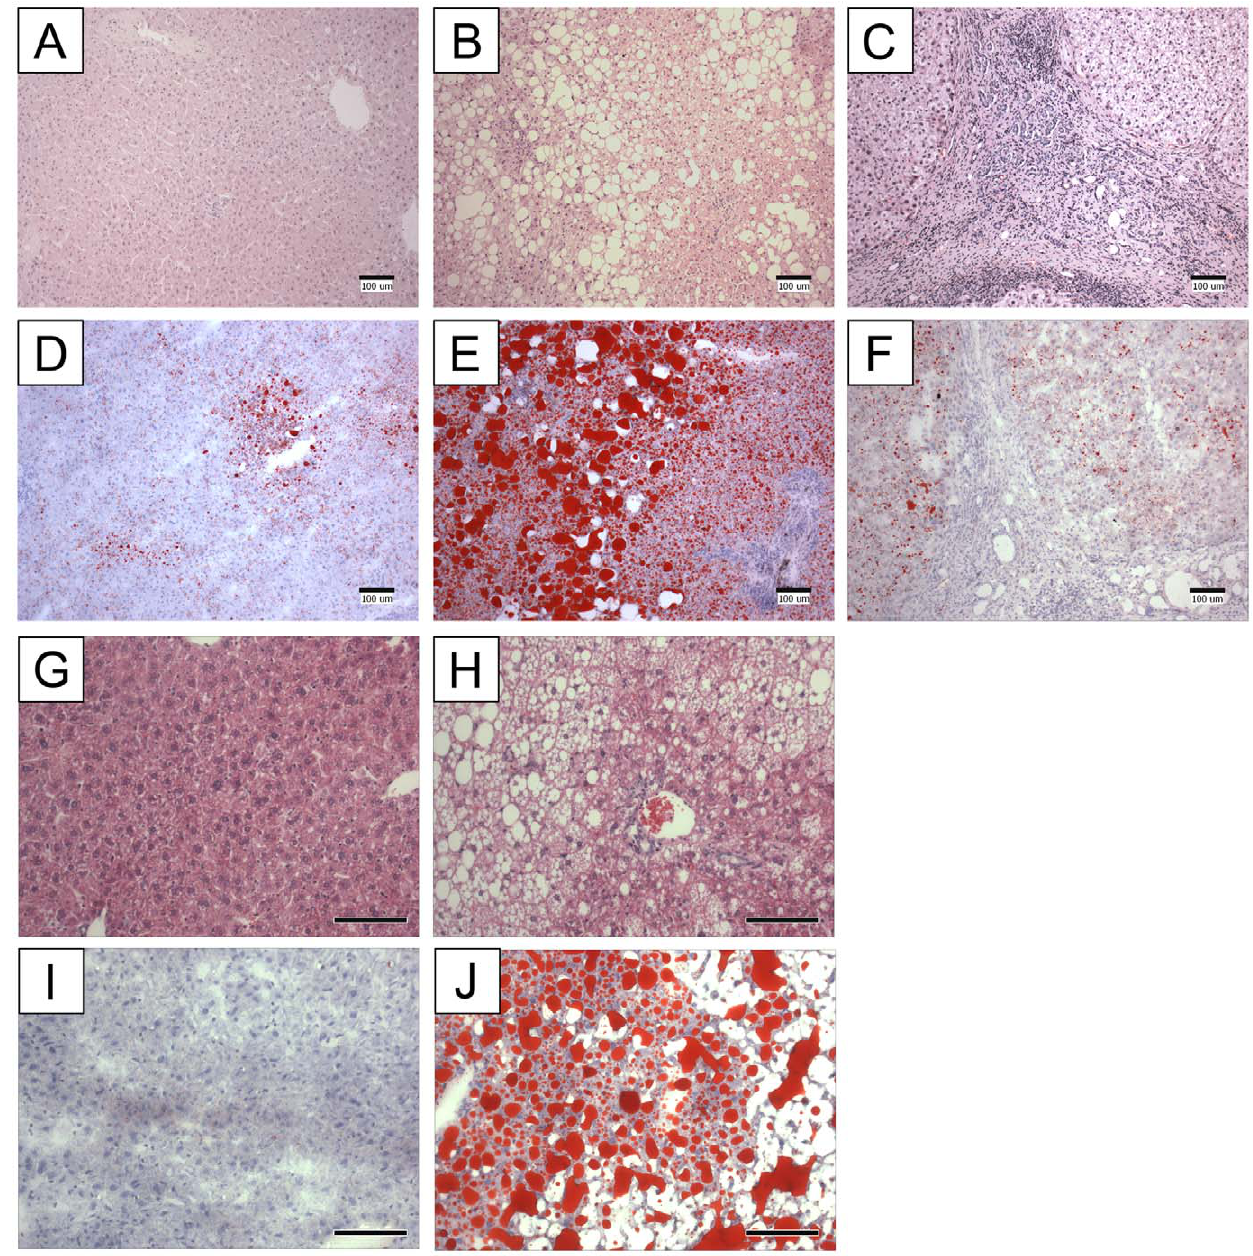
Figure 1. Panels A–F show histological progression of nonalchoholic fatty liver disease in human biopsies. ( A,B,C ) show hematoxylin and eosin (H&E) staining, and ( D,E,F ) show oil red O (ORO) staining. ( A,D ) normal; ( B,E ) steatohepatitis; ( C,F ) cirrhosis. In ( A ) normal lobular architecture of the liver is observed, with little fatty change on ORO staining in ( D ). Changes with progression to steatosis are seen with increased fat globules. The presence of inflammatory cell infiltrates ( B ) and lipid droplets are prominently visible in ( E ). Cirrhotic changes show characteristic fibrotic pattern ( C ) and a paucity of staining with ORO in ( F ). Panels G – J show histology of normal murine liver specimens. (G) H&E staining as well as oil red O staining (H). Fatty liver disease in murine tissues is histologically demonstrated by H&E (I) and using oil red O staining (J). steatotic livers compared to normal but minimally detectable in the cirrhotic livers. To ensure that the changes observed reflected strong differences between disease states, the DAG levels were compared by gender as well. No differences with p , 0.01 were found between genders (data not shown).